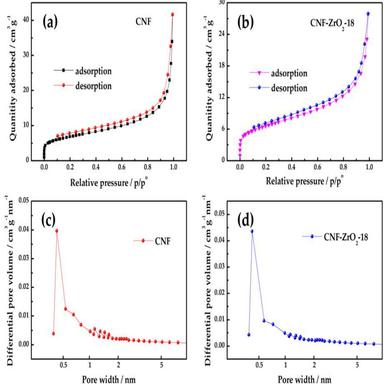
N2 adsorption/desorption isotherms of CNF (a) and CNFeZrO2-18 (b), pore size distributions of CNF (c) and CNFeZrO2-18 (d).